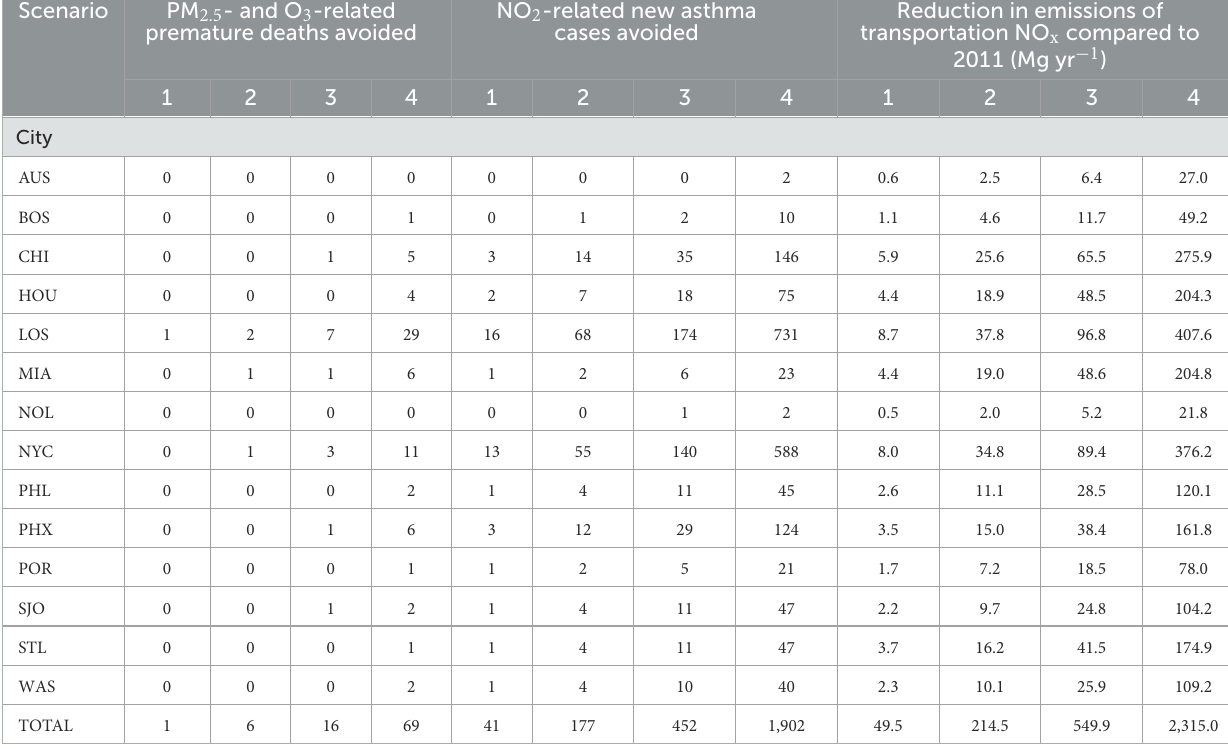
TABLE 4 Health benefits and emission reductions associated with four proposed emission reduction scenarios (see Table 1) for all 14 study cities if only each city implemented the